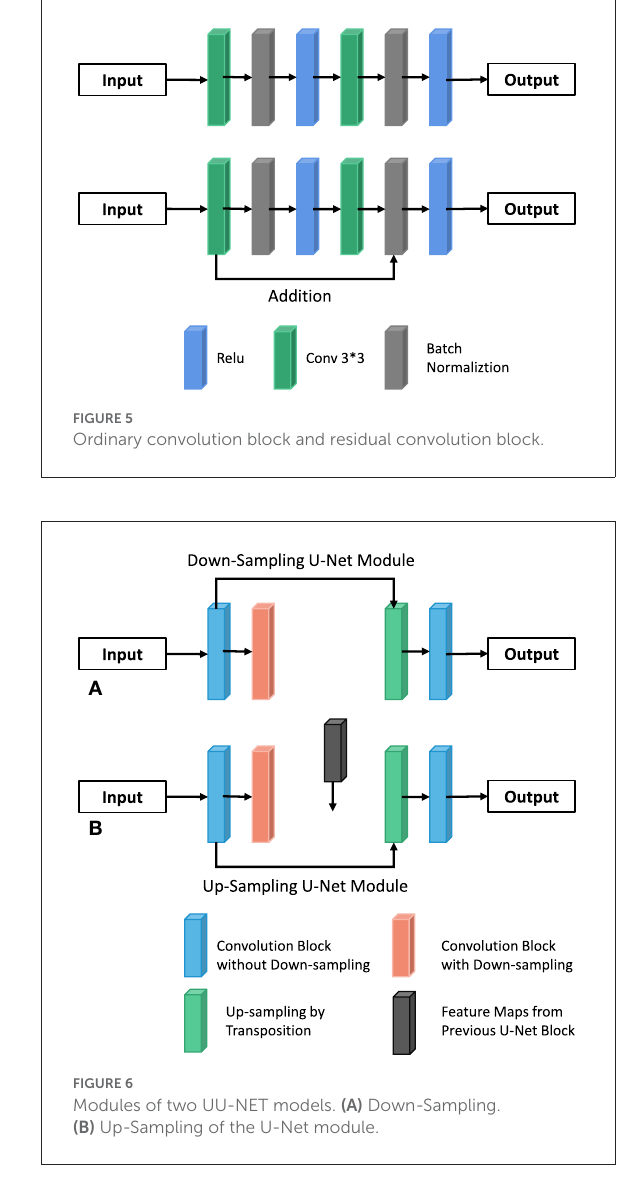
FIGURE6 Modules of two UU-NET models. (A)